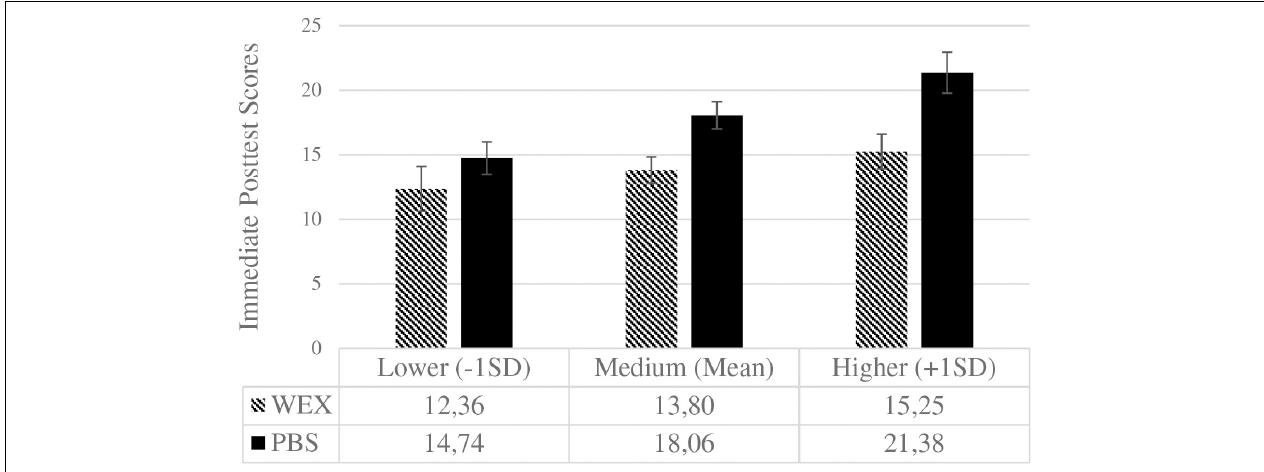
FIGURE 5 | Immediate post-test scores for both learning conditions at different levels of initial performance expectancies. WEX, worked-examples (0), n = 32; PBS, problem-solving (1), n = 28. Error bars represent the standard error of the mean [WEX: 1.73 (–1SD), 1.02 (Mean), 1.33 (+1SD); PBS: 1.26 (–1SD), 1.06 (Mean), 1.58 (+1SD)]. Performance expectancies (standardized) are depicted for lower, medium, and higher levels. Post-test scores could range from 0 to 42.